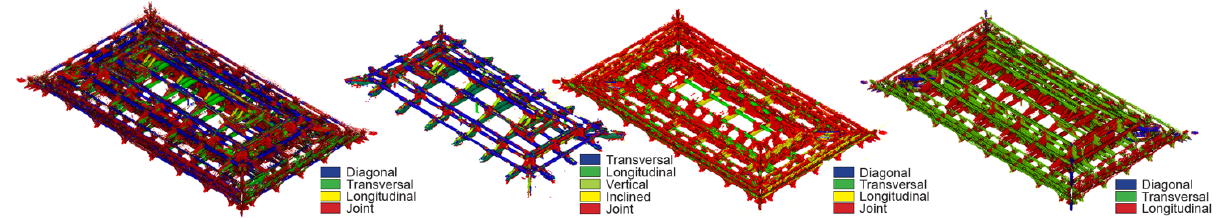
Figure 10. FKS truss classification tests in the 3rd MLMR classification level.